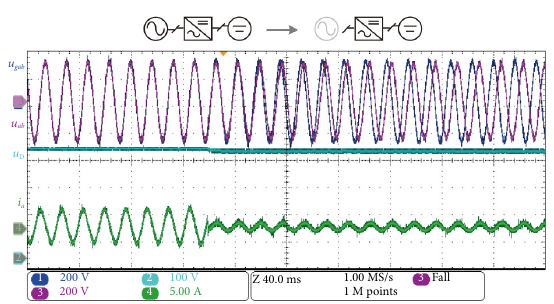
Fig. 7 Switching process from the balanced mode to the dc dominant mode with the VSSM loop.